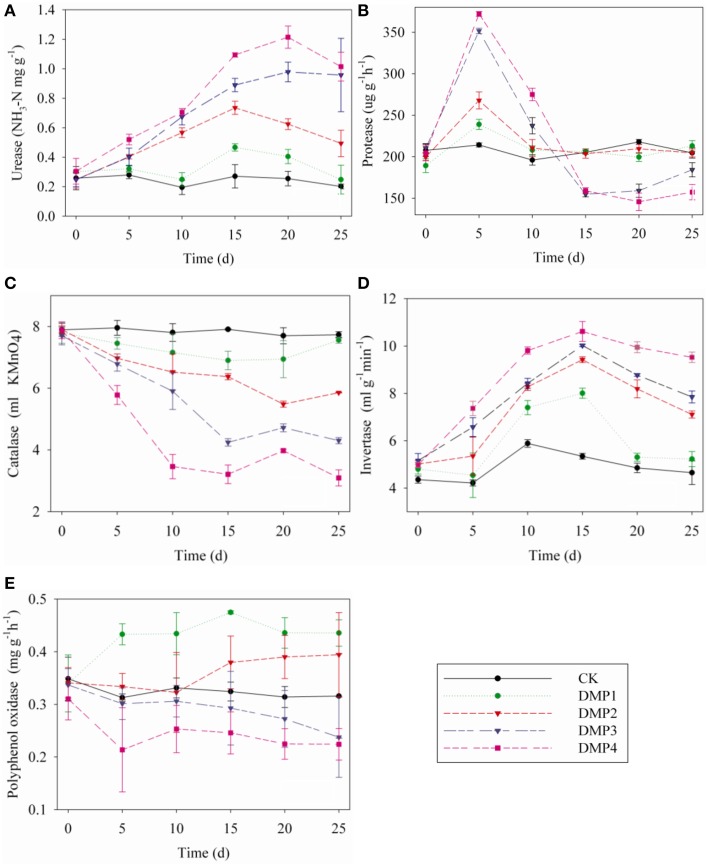
Effects of DMP contamination on the enzyme activities from black soil microorganisms with 25 days incubation in the dark at 25°C and 70% relative humidity. DMP concentration varied from 0 to 40 mg/kg soil (CK, DMP1, DMP2, DMP3, and DMP4). (A) Urease; (B) Protease; (C) Catalase; (D) Invertase; (E) Polyphenol Oxidase. The error bars indicate standard deviations (n = 3).